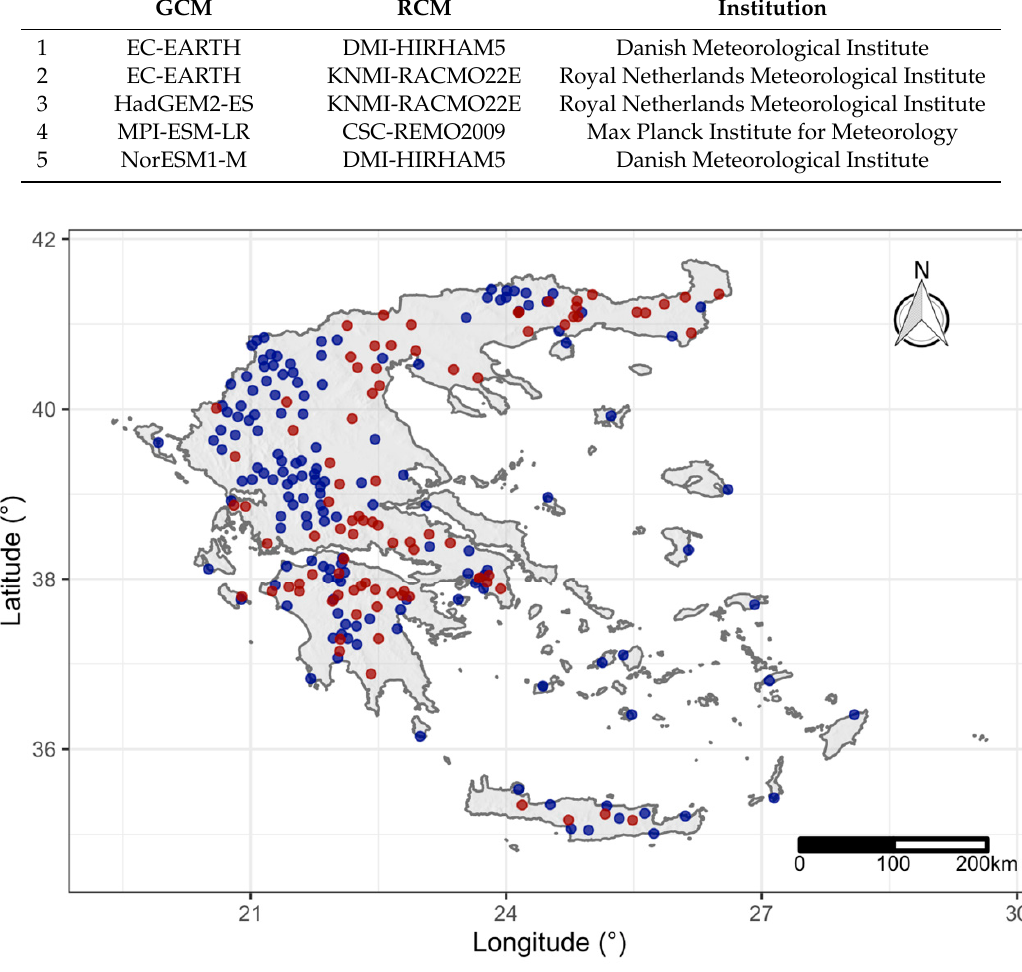
Table 1. Global Circulation Models (GCMs)-Regional Climate Models (RCMs) used in the analysis (i.e., data retrieved from EURO-CORDEX). GCM RCM